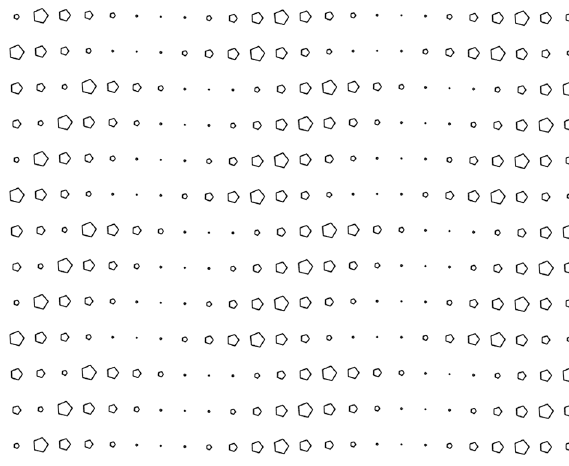
Fig. 11 EmPatGen